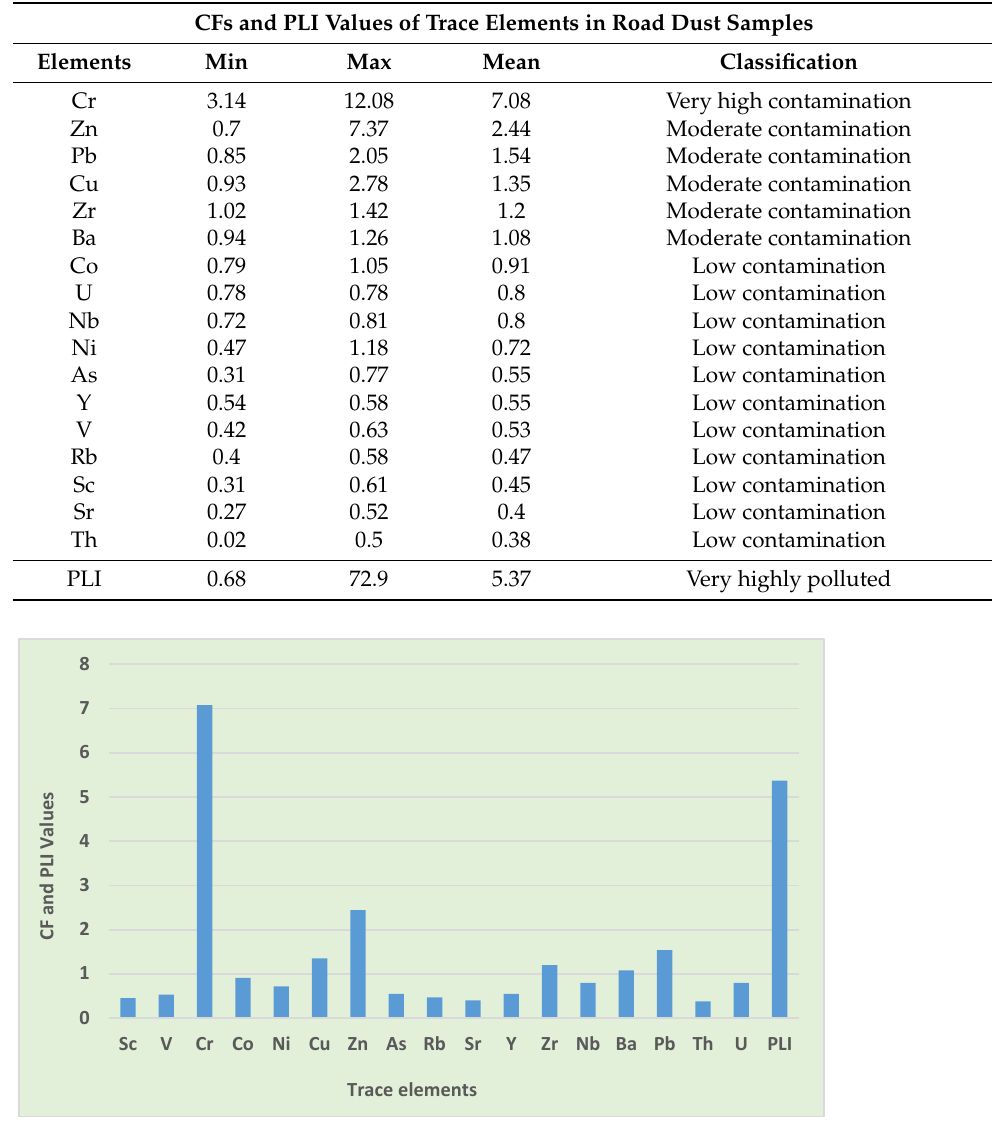
Figure 4. Contamination factor and pollution load index of individual trace elements in road dust.